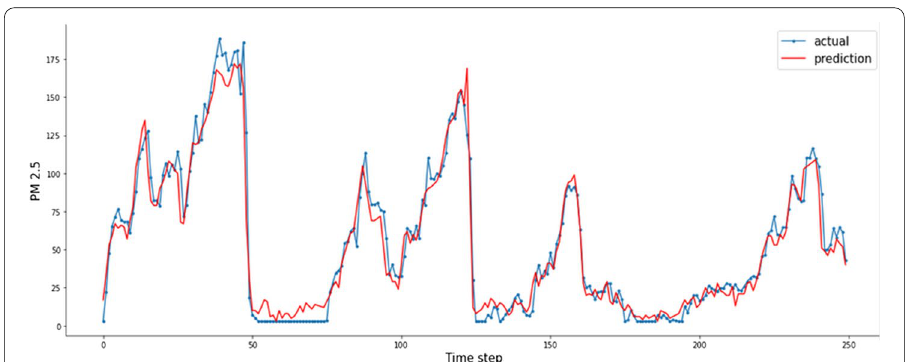
Fig. 16 PM2.5 concentration forecasting results for 10 days